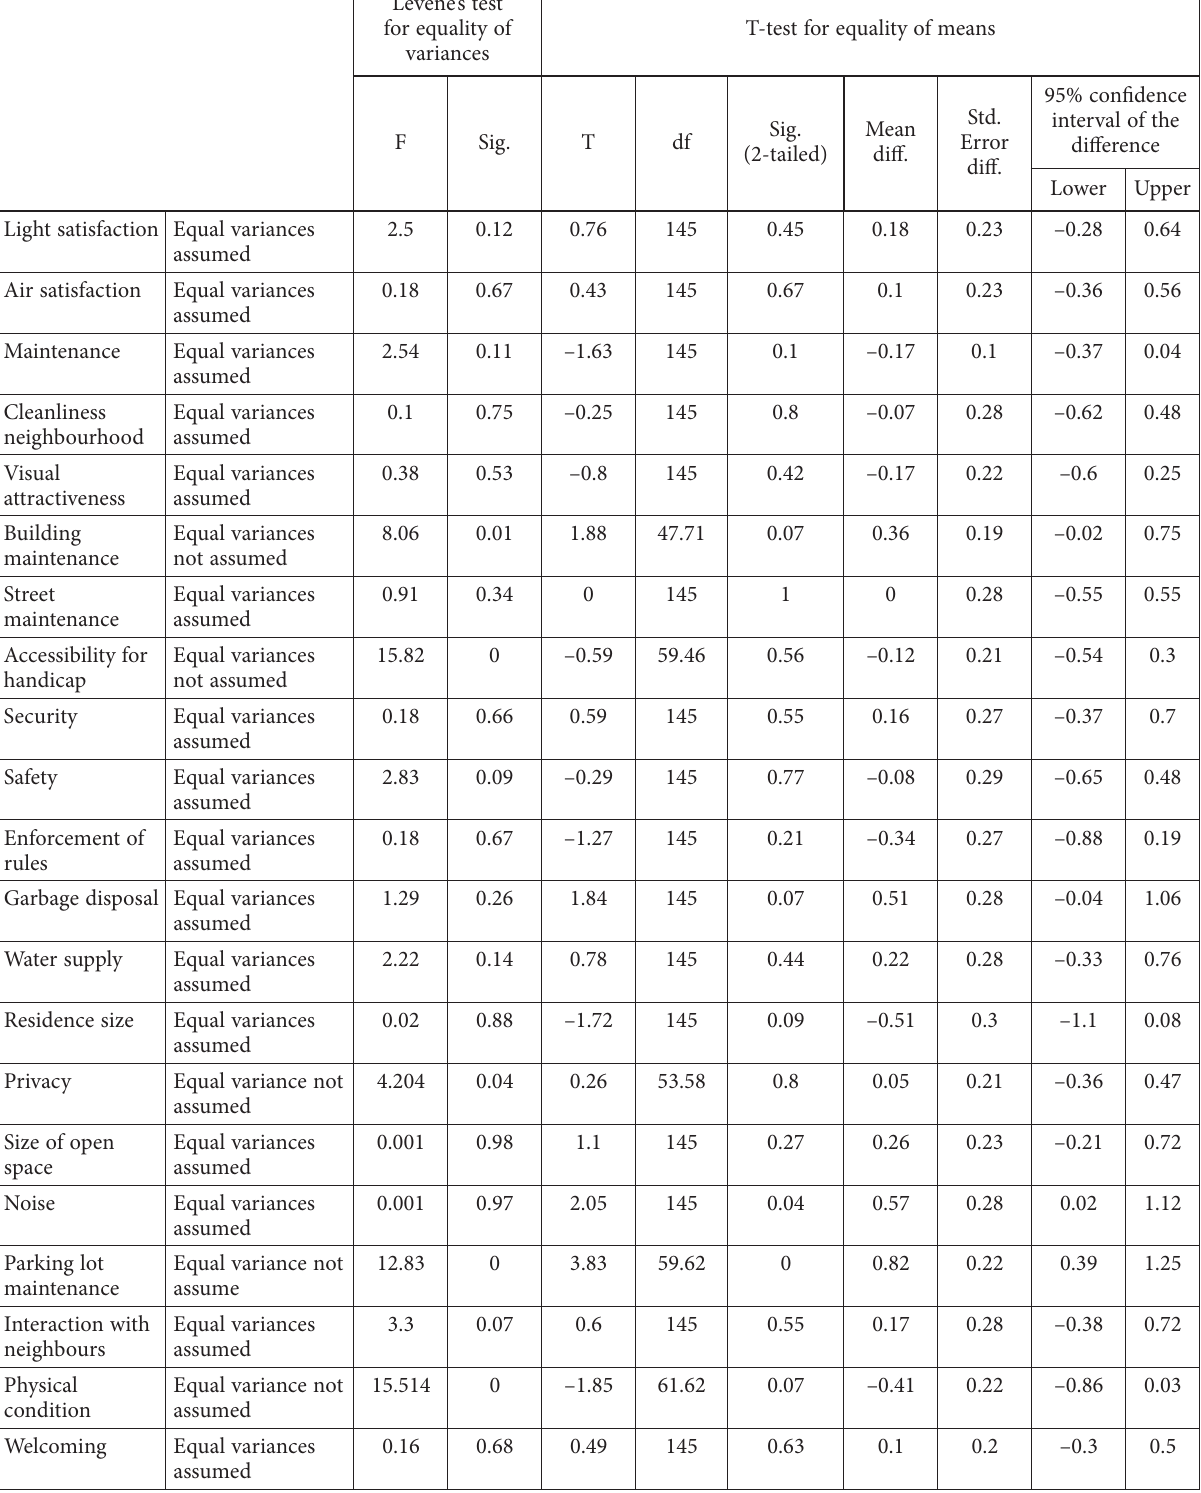
Table 5. T-test of significance between house type and residential satisfaction in Islamabad (source: field survey) Levene’s test for equality of T-test for equality of variances